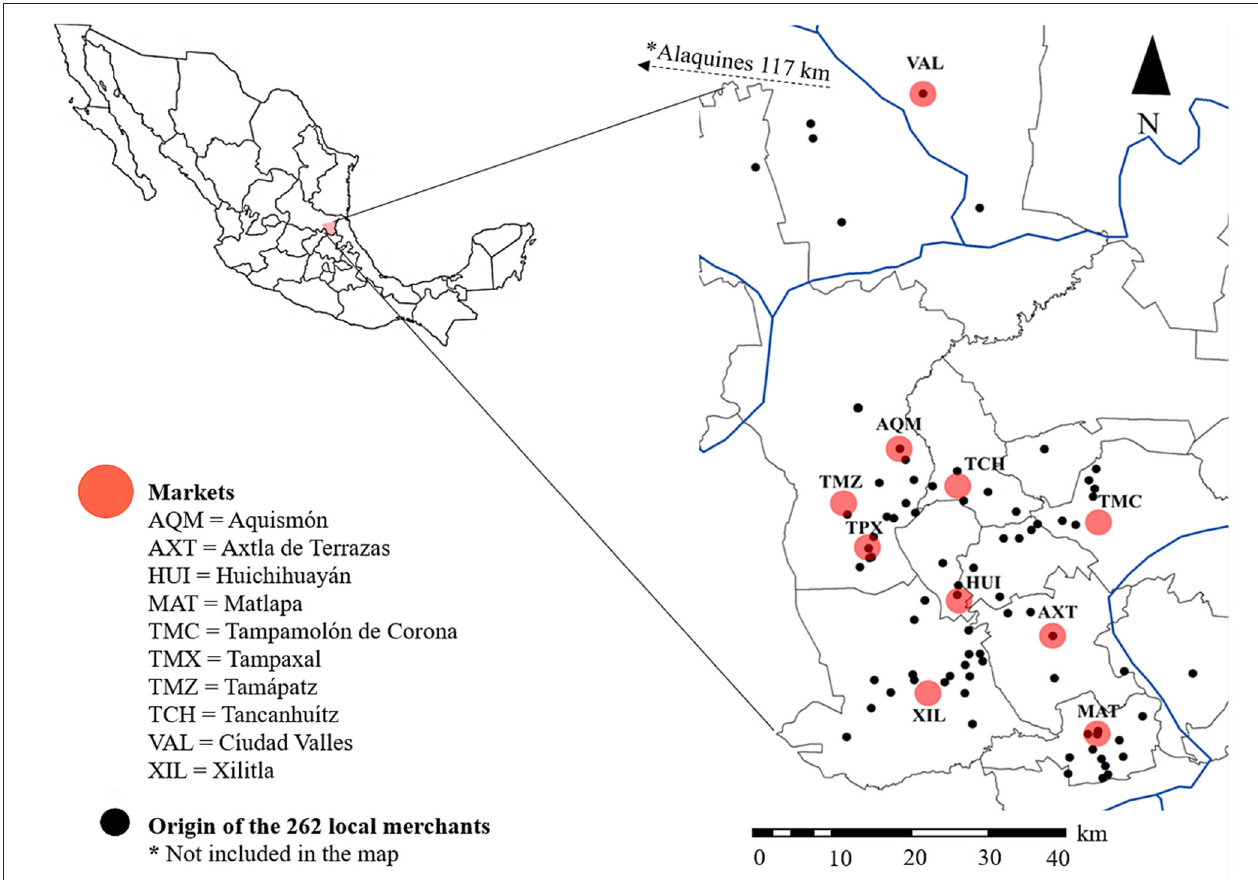
FIGURE 1 | Location of the markets in the Huasteca Potosina included in this study and the communities of origin of the local